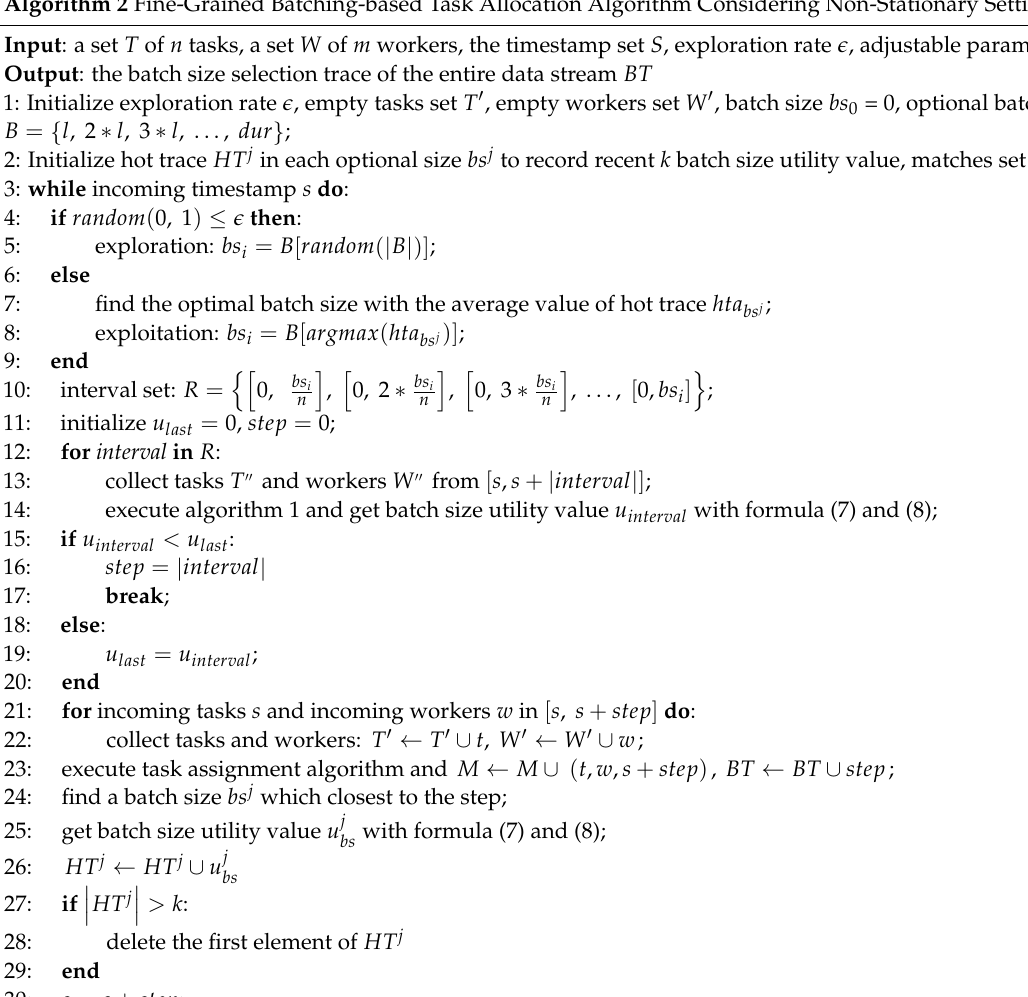
Algorithm 2 Fine-Grained Batching-based Task Allocation Algorithm Considering Non-Stationary